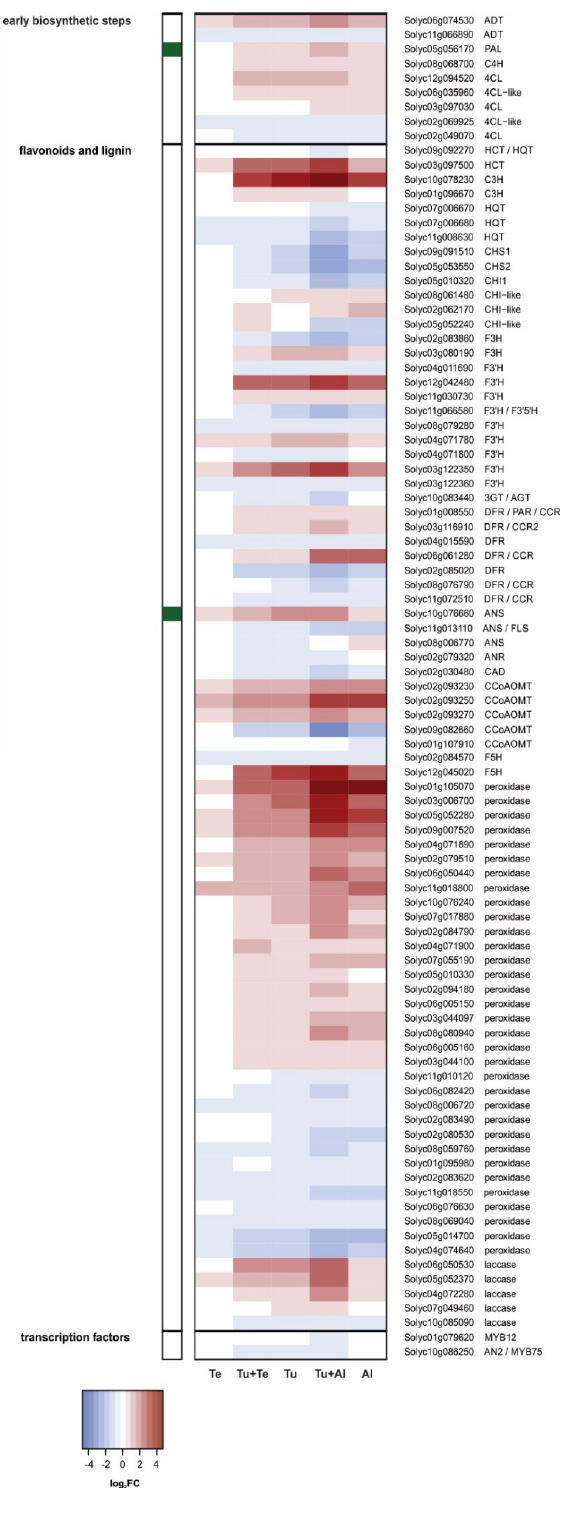
Figure 5. Gene-expression heat map depicting the relative transcript levels of tomato ( Solanum lycopersicum ) genes that encode proteins with a (predicted) function in the phenylpropanoid pathway and that were differentially expressed in leaves after seven days of infestation with herbivorous mites. Tomato leaves were infested with either a single mite species ( Tetranychus urticae (Tu), Tetranychus